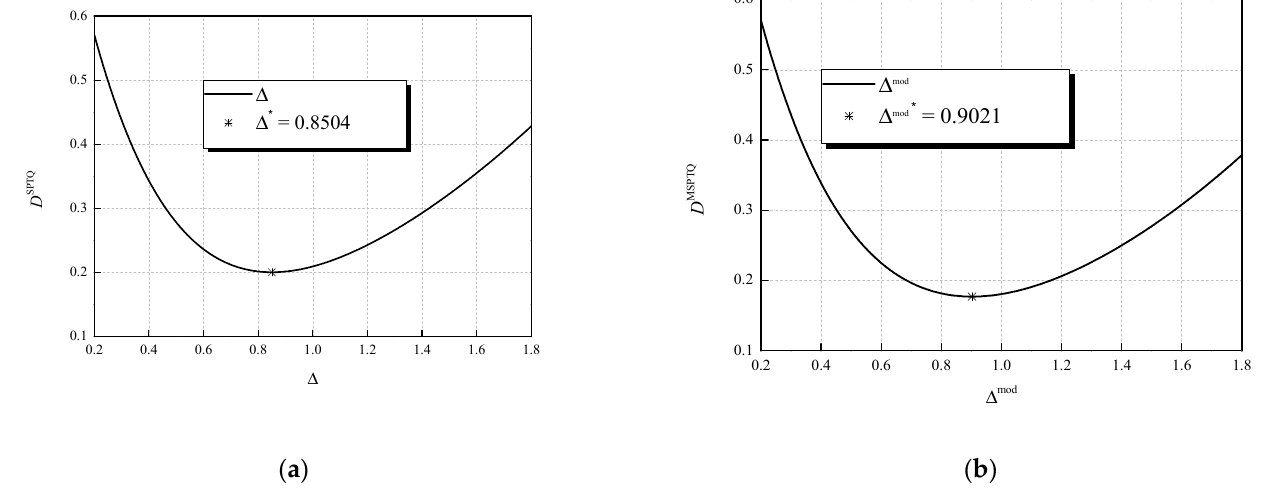
Figure 6. Distortion dependance on the corresponding basic step size for ( a ) SPTQ and ( b ) MSPTQ. The support region in our Case 1 is defined as [ − min(| w min |,| w max |), min(| w min |,| w max |)], which is in our experiment simply [ − w max , w max ]. Therefore, in Case 1,